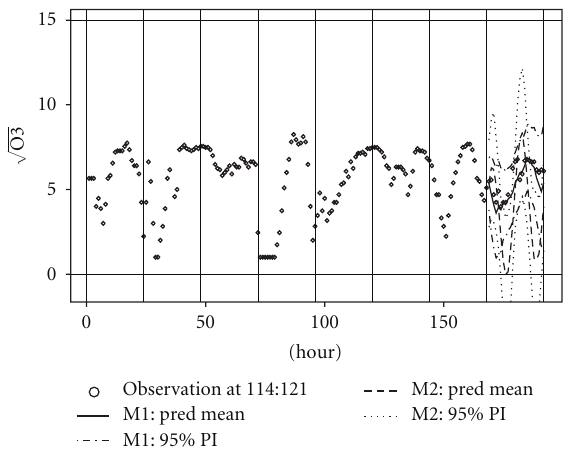
Figure 2: The observed square-root of ozone concentrations (cid:20) ( ppb) from Day 114 to Day 121, the predicted values using M1 and M2, and their 95% pointwise predictive intervals at GS